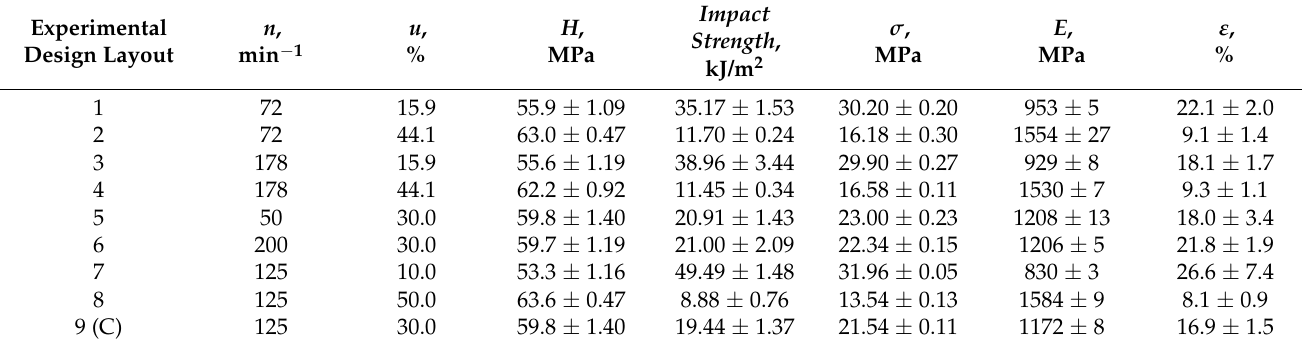
Table 2. Experimental design and experimental test results—mean values and standard deviation—part II. Experimental Design